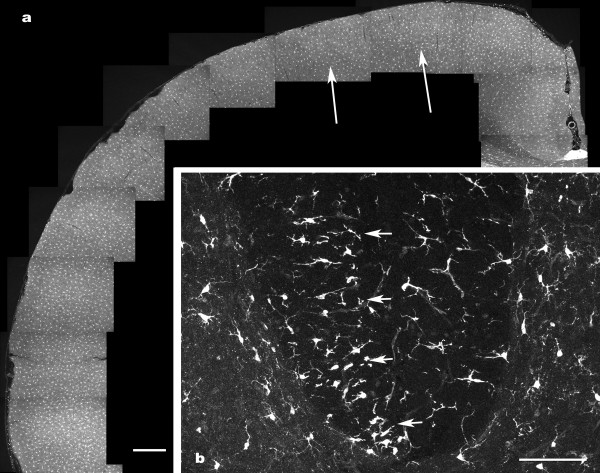
β thymosin immunoreactivity in the motor cortex 7 days following unilateral pyramidectomy. The panel (a) is a montage showing the absence of increased microglial staining in the motor cortex (arrowed) compared with adjacent cortex. The panel (b) shows the unilateral microglial reaction in the degenerating dorsal corticospinal tract (arrows) from the same animal. Both scale bars are 100 μm.